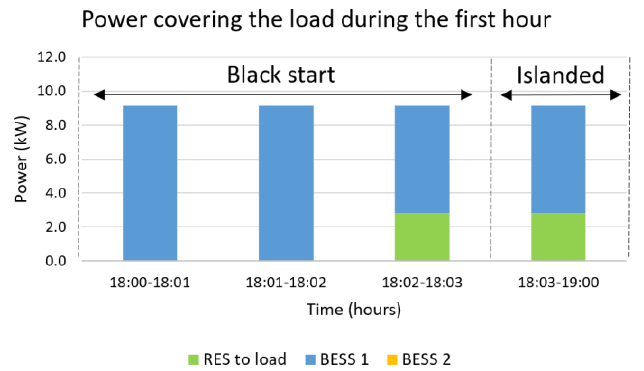
Figure 12. Power covering the load during the first hour for a black start at 18:00 followed by islanded operation until 21:00.